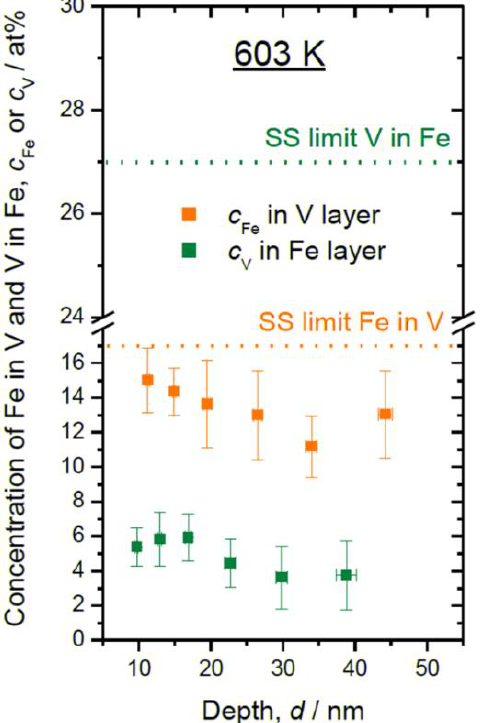
Figure 7. In-layer composition of Fe in V layers ( c Fe ) and V in Fe layers ( c V ) plotted against the sample depth, as detected at 603 K. Solid solubility limits (SS limit) at 603 K for bulk system [31] are marked with dotted lines.